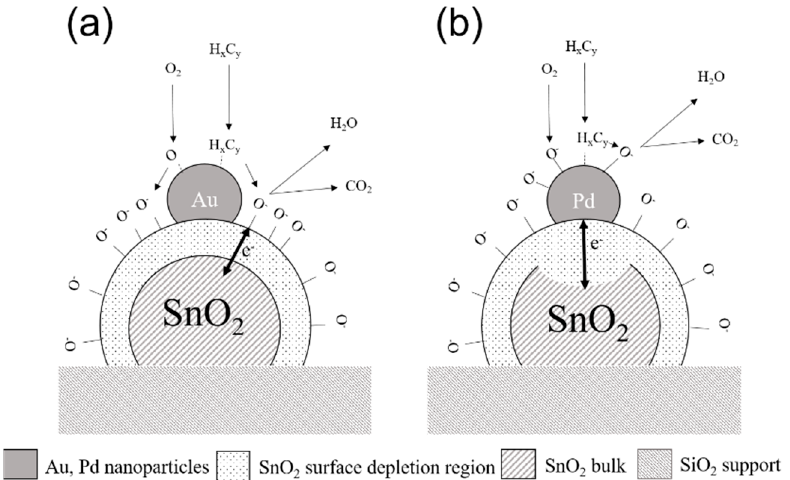
Figure 13. A schematic diagram of the gas sensing mechanism of polycrystalline SnO 2 functionalized with ( a ) gold nanoparticles with the primarily chemical (spill-over) type of sensitization, and ( b ) palladium nanoparticles with the primarily electric (Fermi level) sensitization type.